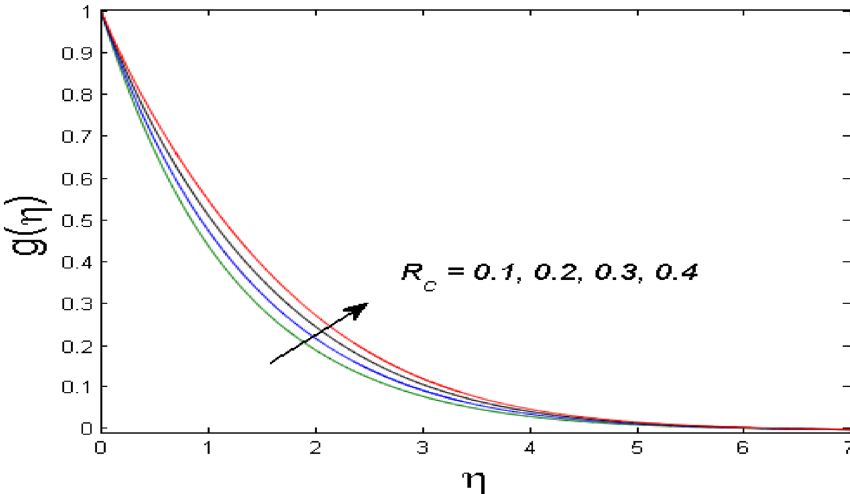
Figure 13. g (η) versus varied estimates of R c .